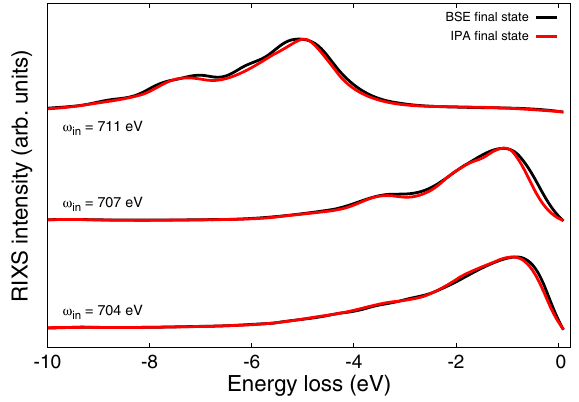
FIG. 12. RIXS spectra calculated using the full Kramers- Heisenberg formula by Eq. (8). Intermediate-state excitonic interactions are treated at the BSE level, while final-state excitonic interactions are evaluated either with the BSE kernel (black curves) or at the independent particle level (red curves). For all sets of curves, the intermediate (final) state HWHM broadening is 0.20 eV (0.36